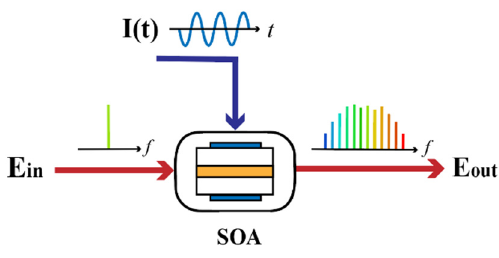
Figure 1. The schematic diagram of the OFC based on single-tone modulation and FWM effect in an SOA.